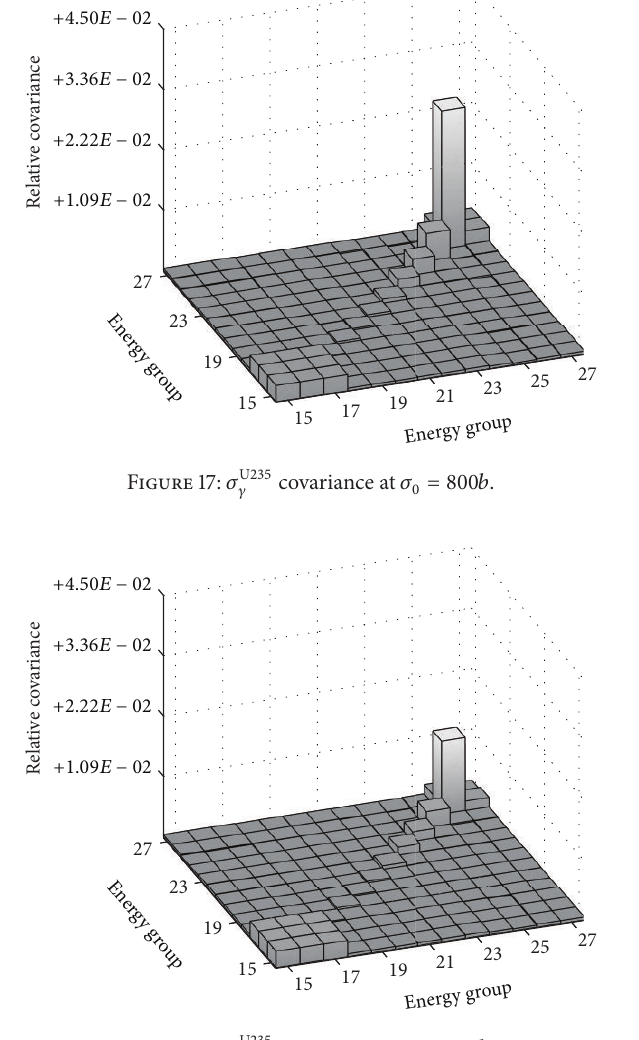
Figure 18: 𝜎 U 235 𝛾 covariance at 𝜎 0 = 200𝑏 .